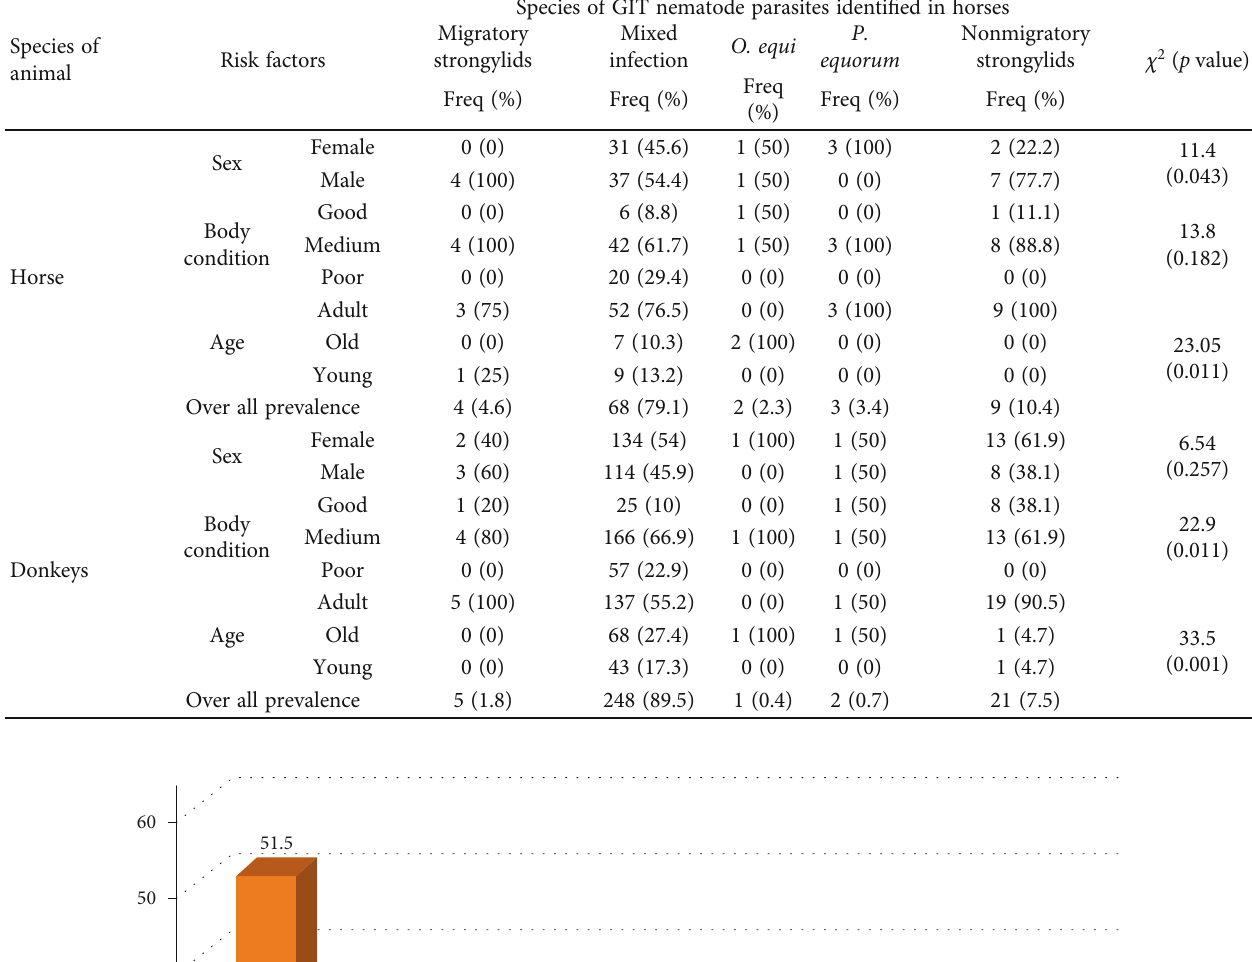
Table 4: Species wise prevalence and their associated risk factors for the occurrence of GIT nematodes. Species of